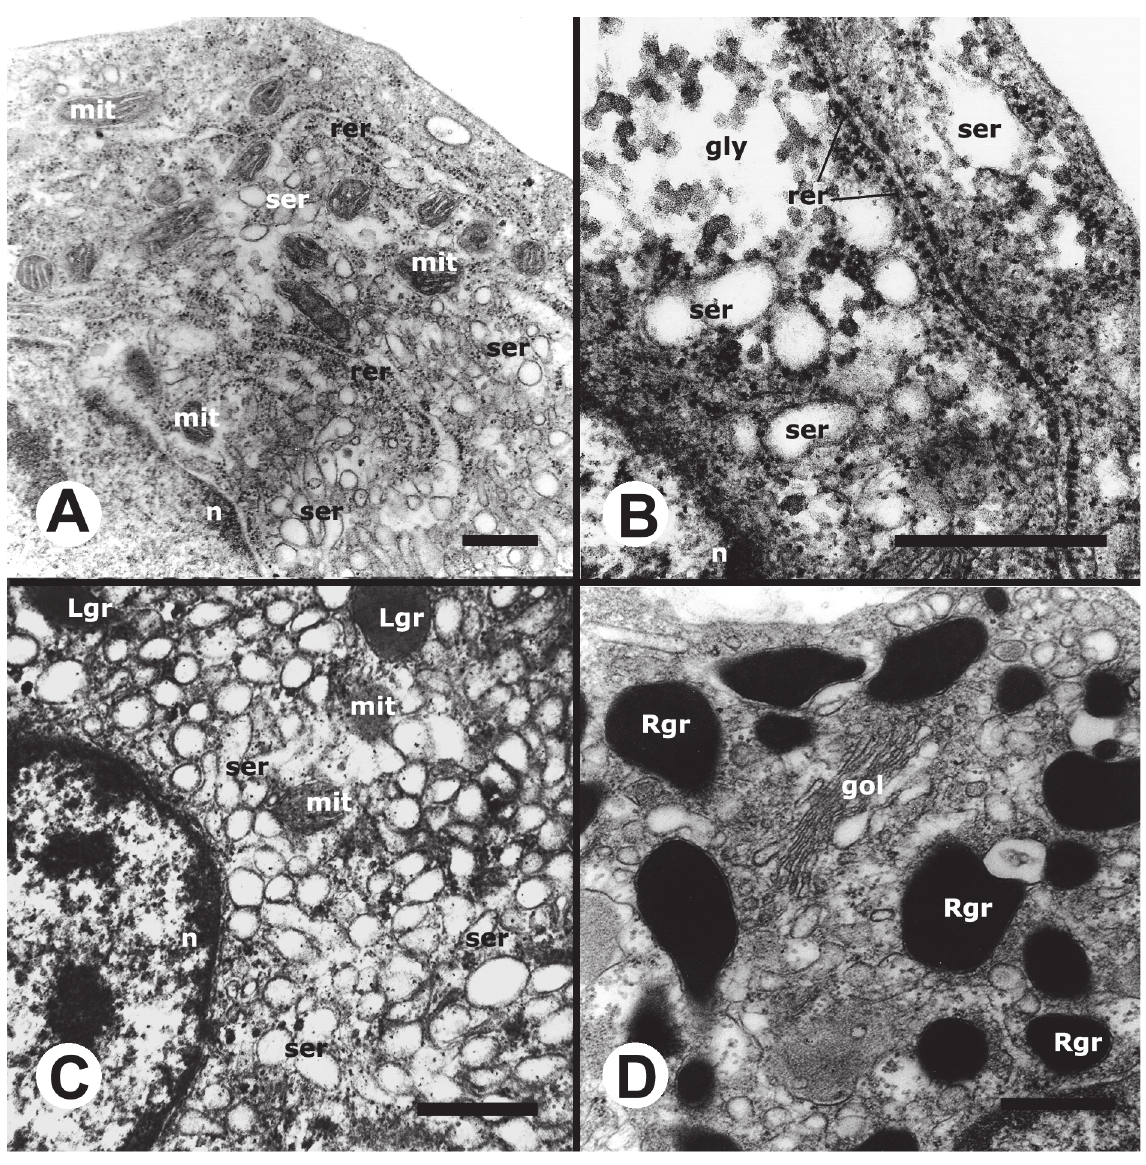
Fig 4. Details of circulating hemocytes (TEM). (A) Cytoplasm of a hyalinocyte showing numerous mitochondria and some RER and SER profiles. (B) Detail of another hyalinocyte showing an extended RER cisterna, SER vesicles and a membrane-unbound zone with presumptive glycogen granules. (C) Cytoplasm of a hyalinocyte showing numerous SER vesicles, as well as a few L granules and mitochondria. (D) Cytoplasm of a granulocyte showing numerous R granules around a Golgi complex. Abbreviations: gly , presumptive glycogen granules; other abbreviations as in Fig 3. Scale bars represent 1 μ